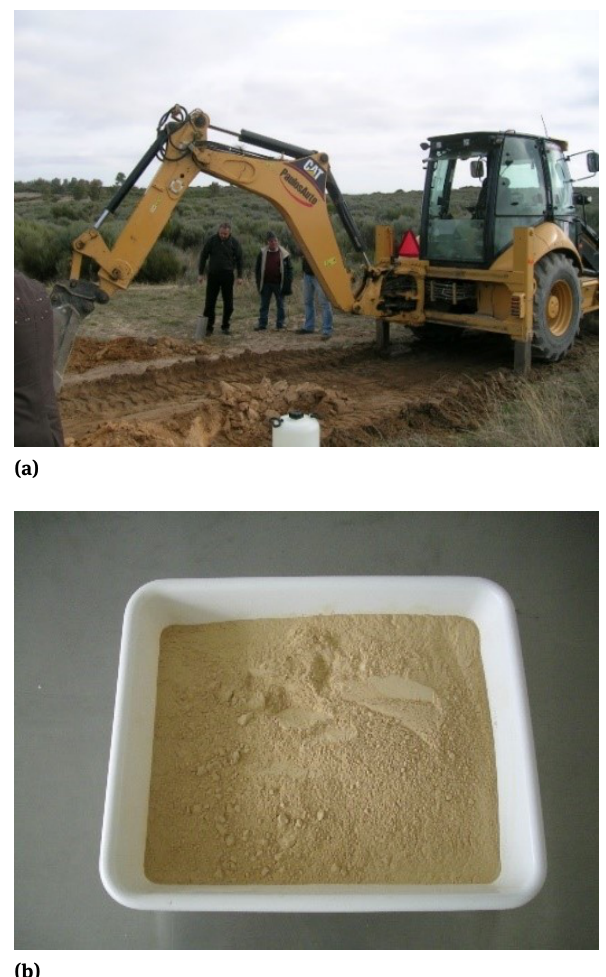
Figure 2: Pickling process for collecting the soil sample, in the se- lected site for the infiltration of treated wastewater (Quinta Gonçalo Martins, Guarda, coordinates M = 287699 m and P = 387657 m): colleting raw samples (a); sample of fine soil (b)